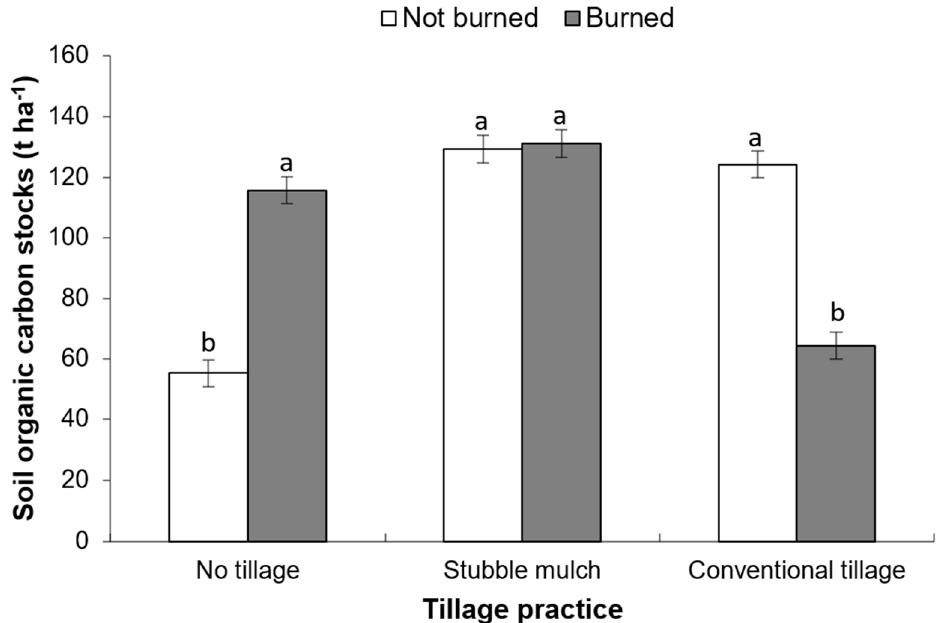
Figure 4. The interaction effect of tillage and wheat straw management on the total carbon stocks (0–1000 mm). Error bars represent the standard errors of the mean and different letters (a,b) in the bars represent significant differences at p < 0.05 according to Tukey’s multiple comparison test.